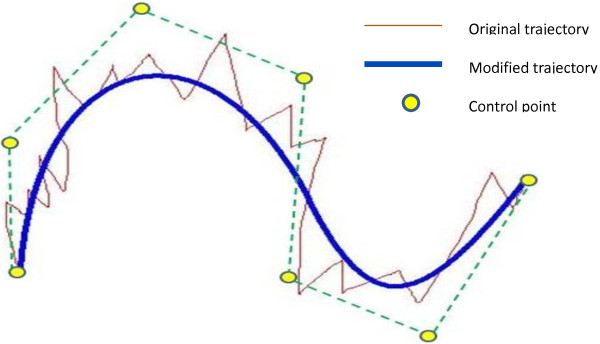
The NURBS curve.